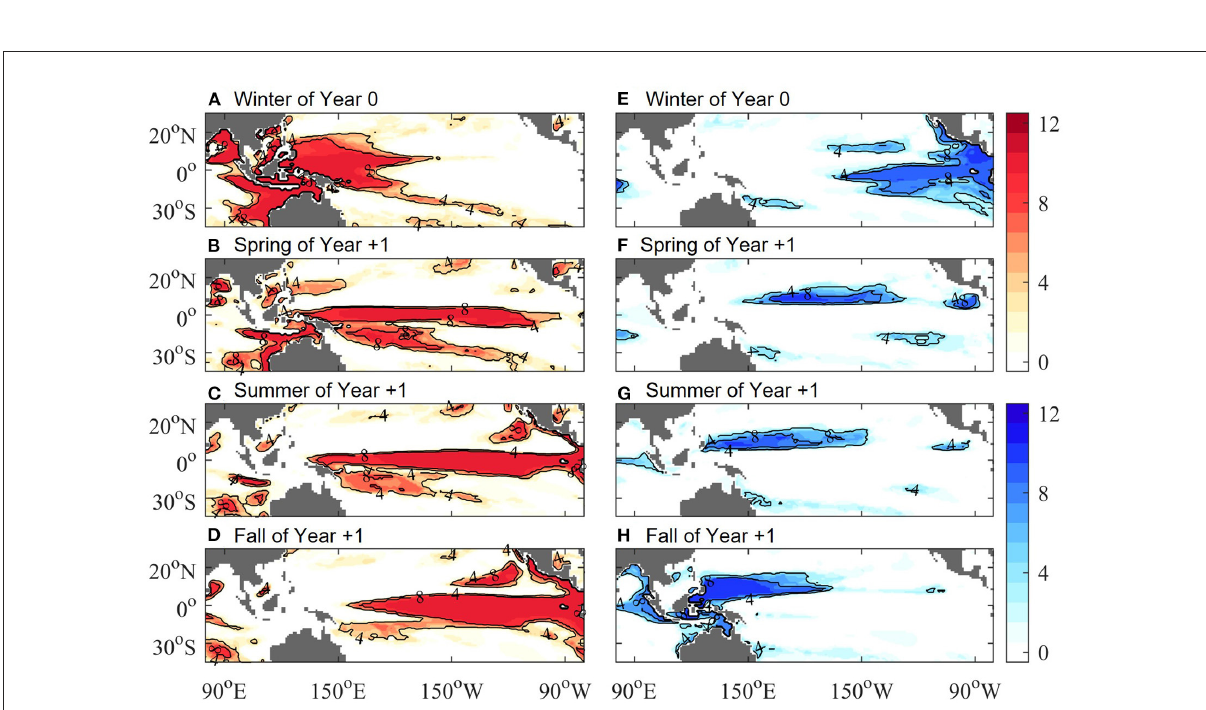
FIGURE13 Numbers of ensemble members of the CNRM-CM5 model with significant positive correlations between the STIO SSHA in fall and the tropical Indo-Pacific Oceans SSHA in (A) winter of Year + 0, (B) spring of Year + 1, (C) summer of Year + 1, and (D) fall of Year + 1. (E–H) are same as (A–D) , but for significant negative